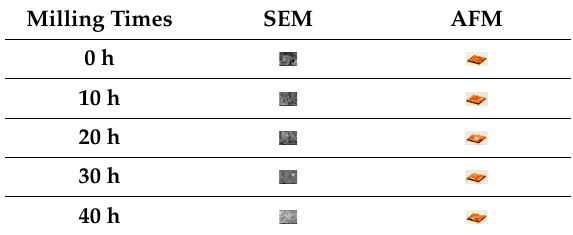
Figure 5. The S.A.E.D. images of coconut shell particles for various milling times, ( a ) for 0 h, ( b ) for 10 h, ( c ) for 20 h, ( d ) for 3 h, and ( e ) for 40 h. Table 2. SEM and AFM images of the coconut shell nanoparticle at milling time 0, 10, 20, 30, 40